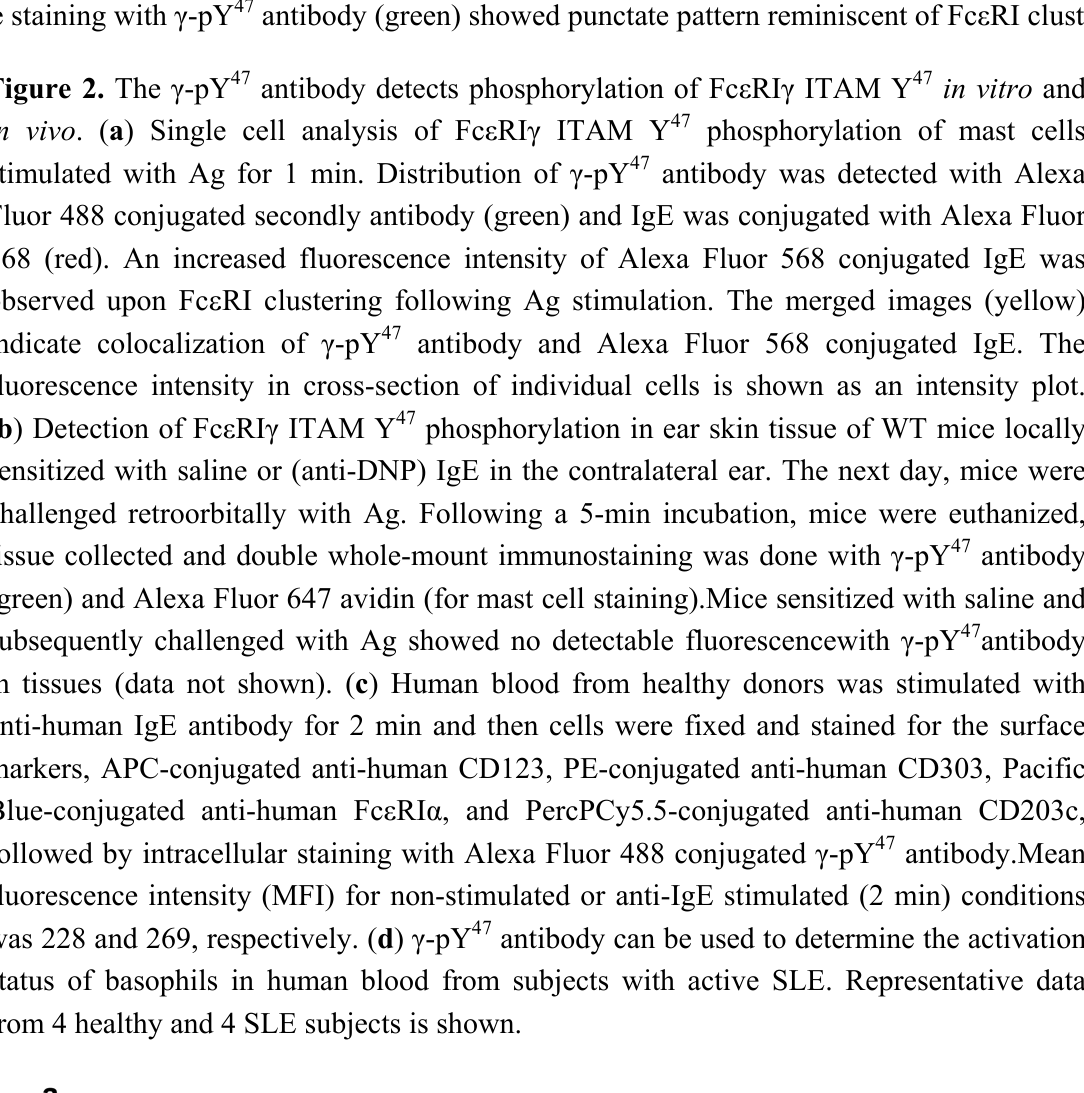
derived from γ chain-deficient mice (Figure 2a: bottom panel). We further tested the utility of γ -pY 47 antibody for immunohistochemistry using skin tissue from the mast cell-dependent mouse model of passive cutaneous anaphylaxis (PCA). Skin samples from the ear of PCA challenged (5 min) WT mice were stained with Alexa Fluor 488 conjugated γ -pY 47 antibody (Figure 2b). Alexa Fluor 647 conjugated-avidin was used to visualize mast cells in skin tissues [22,23]. As shown in Figure 2b, following PCA challenge, mast cells (a single representative cell is shown in red) was observed in the skin and the staining with γ -pY 47 antibody (green) showed punctate pattern reminiscent of Fc ε RI clusters.